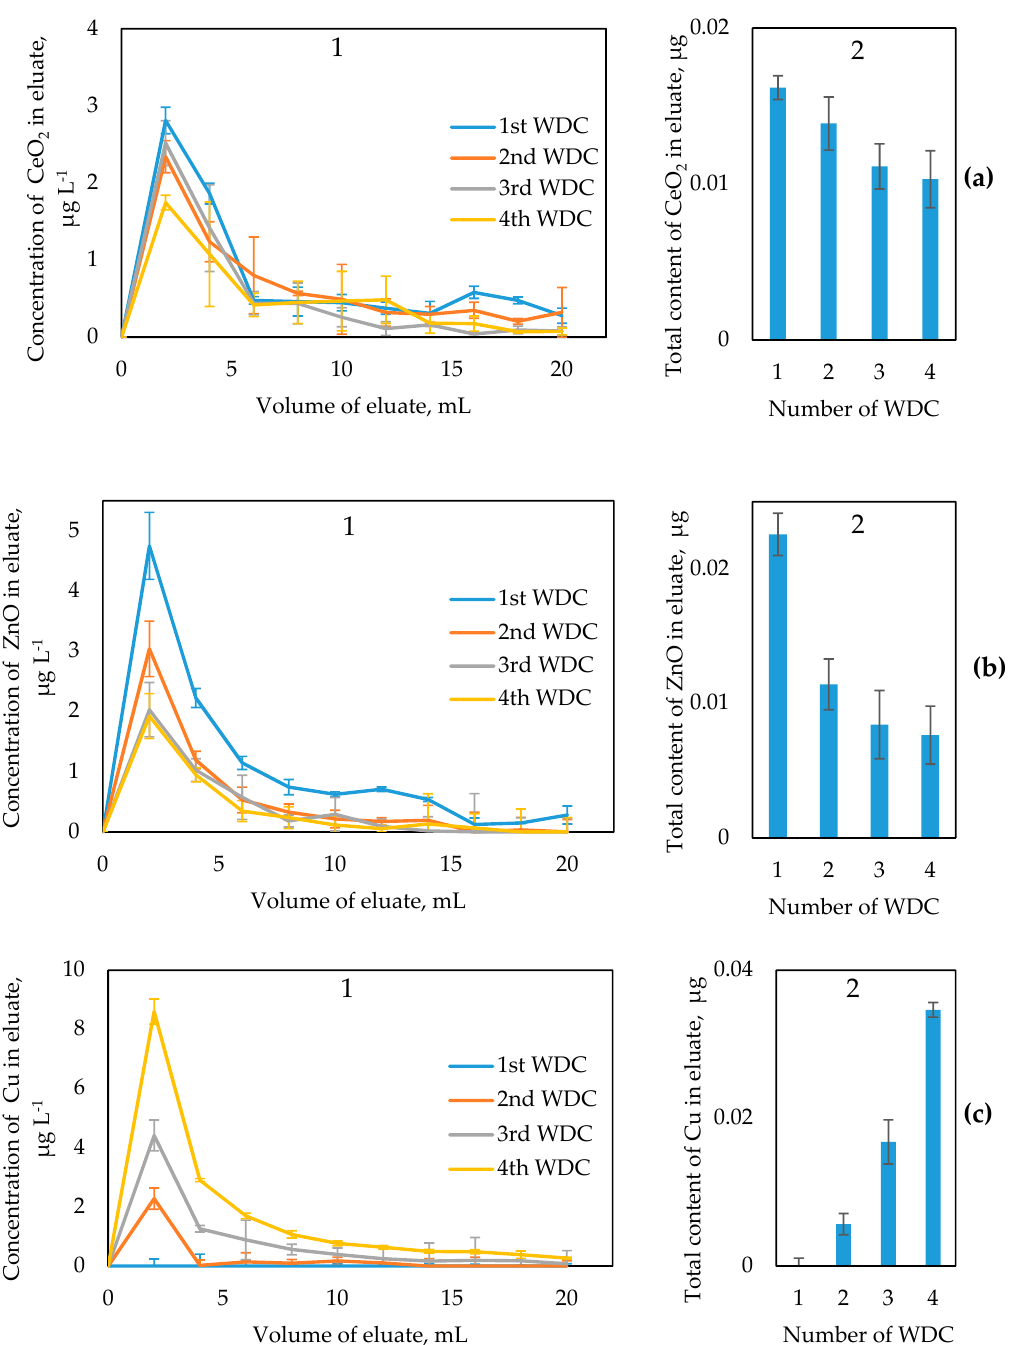
Figure 4. Mobility of CeO 2 ( a ), ZnO ( b ), and Cu ( c ) NPs in soil depending on a number of WDC: ( 1 ) elution curves of NPs, ( 2 ) total content of NPs in leachates. Error bars indicate standard deviation.